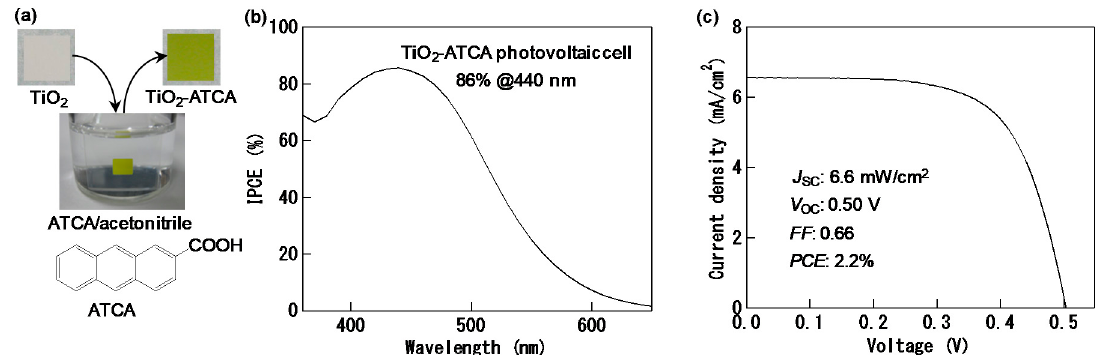
Figure 6. ( a ) Coloration of anatase TiO 2 nanoparticles immersion into the ATCA solution and ( b ) IPCE spectrum and ( c ) J-V curve under simulated solar irradiation (AM1.5G, 100 mW / cm 2 ) of TiO 2 -ATCA photovoltaic cell with iodide electrolyte (LiI: 1 M, I 2 : 0.025 M, solvent: acetonitrile). Adapted with permission from Reference 1. Copyright 2015 Elsevier.